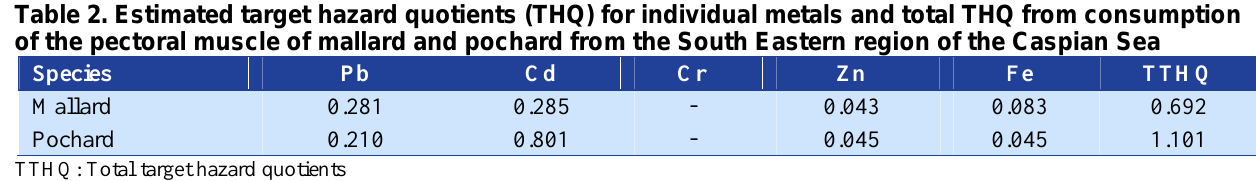
Table 3. The estimated daily and weekly intakes for mallard and pochard flesh by adult humans in the South East of the Caspian Sea Metal PTWI PTWI *